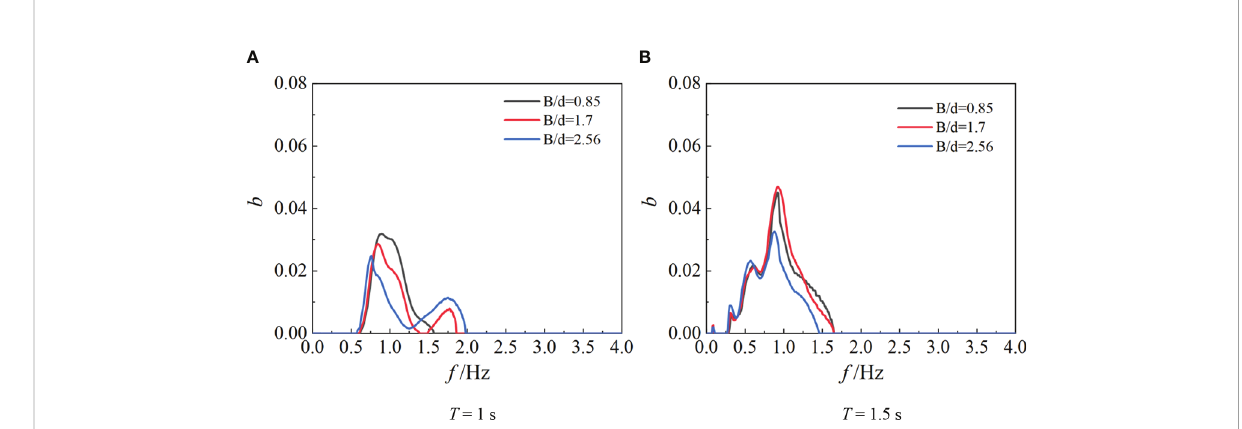
FIGURE 15 Comparison of summed bicoherence under different top widths ( H i = 0.043 m, D = 0.27 m, x = 0.5 m) (A) T = 1 s (B) T = 1.5